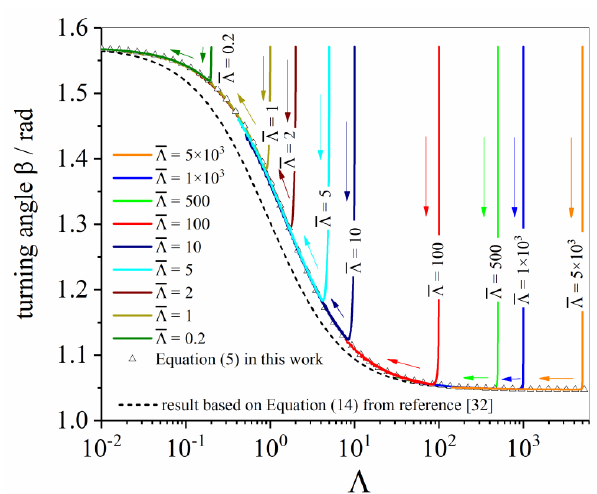
Figure 8. Turning angle β as a function of Λ during the shrinkage of the 4-sided grain for different